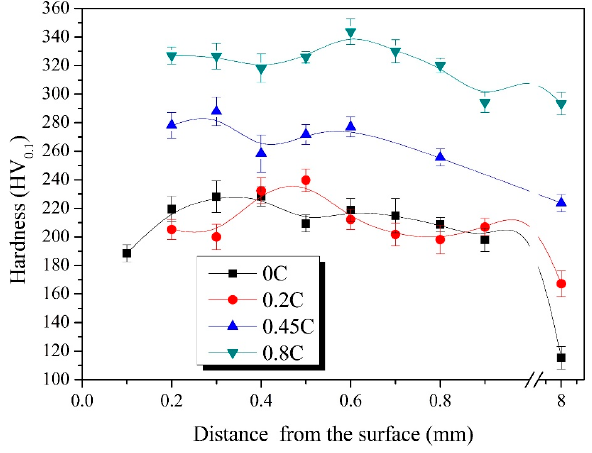
Figure 5. Micro-hardness distributions on the cross-section in the surface layer.